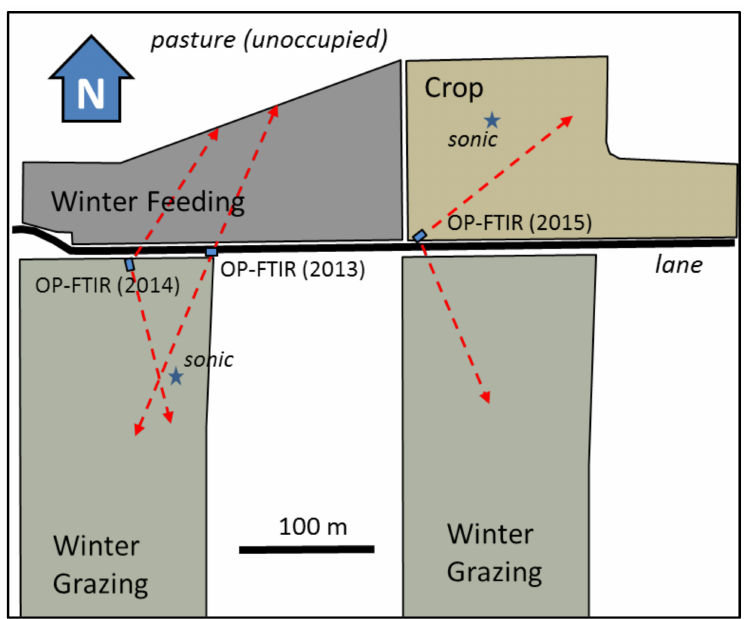
Map of the study site showing the positions of the open-path Fourier transform infrared (OP-FTIR) sensor, the concentration ( C L ) measurement paths (dashed lines), and the sonic anemometers